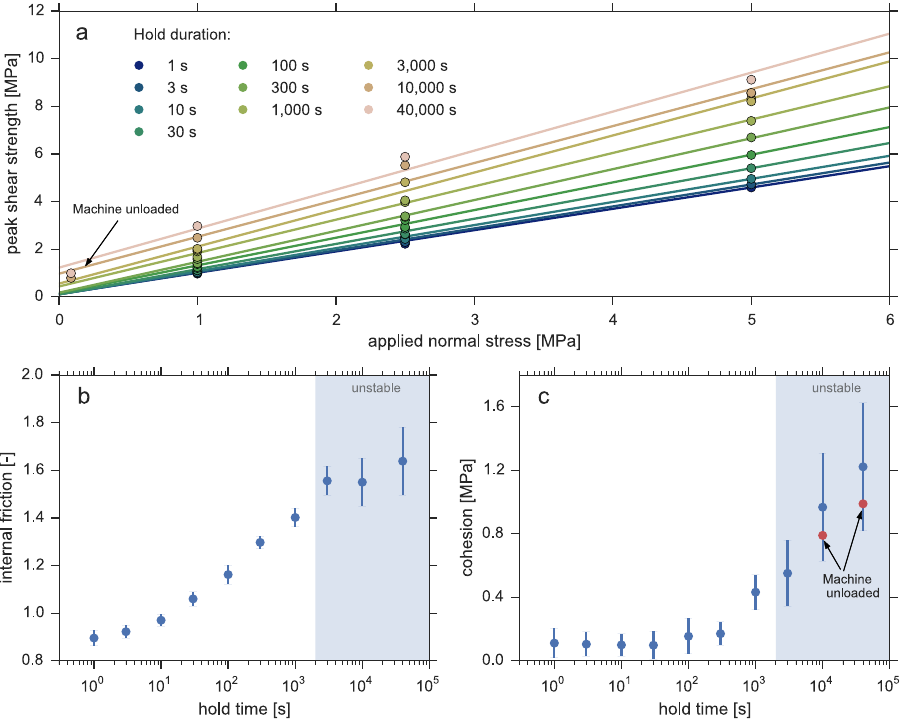
Figure 3. Analysis of the time-dependence of the internal friction coefficient and sample cohesion, as estimated by fitting a Mohr-Coulomb failure envelope to the data. The slope of this linear fit represents the internal friction coefficient, the intercept represents the cohesion. ( a ) Peak shear strength measured during resliding after each hold step, as a function of applied normal stress, and best-fit failure envelopes. Hold durations are indicated in the legend; ( b ) Internal coefficient of friction, as inferred from the slope of the failure envelopes in panel (a) as a function of hold time; ( c ) Sample cohesion, as inferred from the intercept of the failure envelopes as a function of hold time. Measurements done while the machine was unloaded are marked by the two red dots. Error bars indicate the standard error of the parameter estimates resulting from the regression. The shaded area indicates the region of hold durations after which resliding has been oberved to be